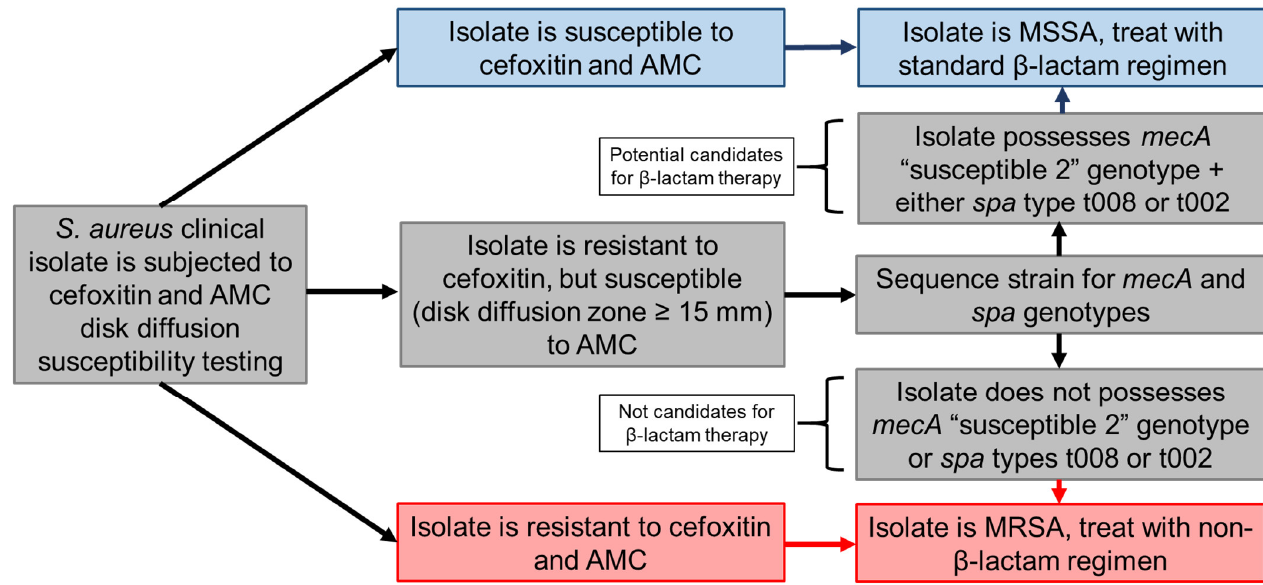
Figure 2. Algorithm for determining MRSA strains which are potentially “β-lactam-susceptible”. Isolates initially deter- mined to be S. aureus are subjected to standard disk diffusion testing (cefoxitin; AMC). Those strains which are resistant to cefoxitin but ‘susceptible’ to AMC, based on a modified breakpoint zone size cut off of ≥15 mm, then undergo targeted genotyping. Only those such isolates which possess both the mecA “susceptible 2” plus either spa type t008 or t002 genotypes would then be considered as potentially “in vivo susceptible” to β-lactams.